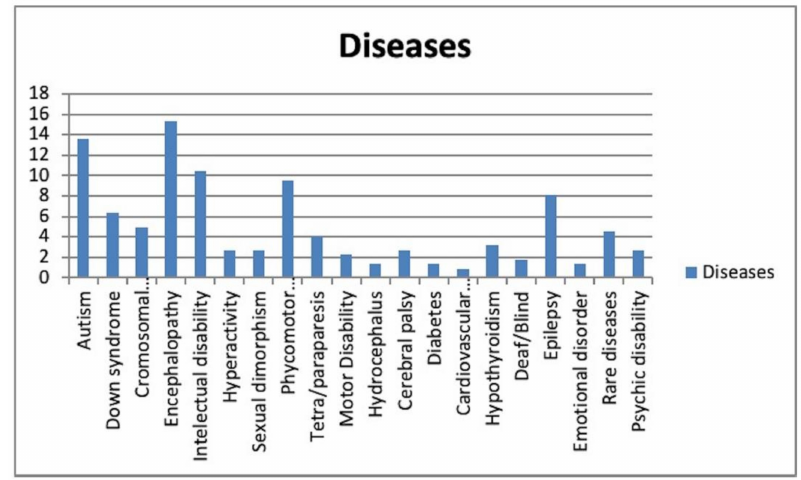
Figure 1. Distribution of the CSHCN based on their medical conditions.